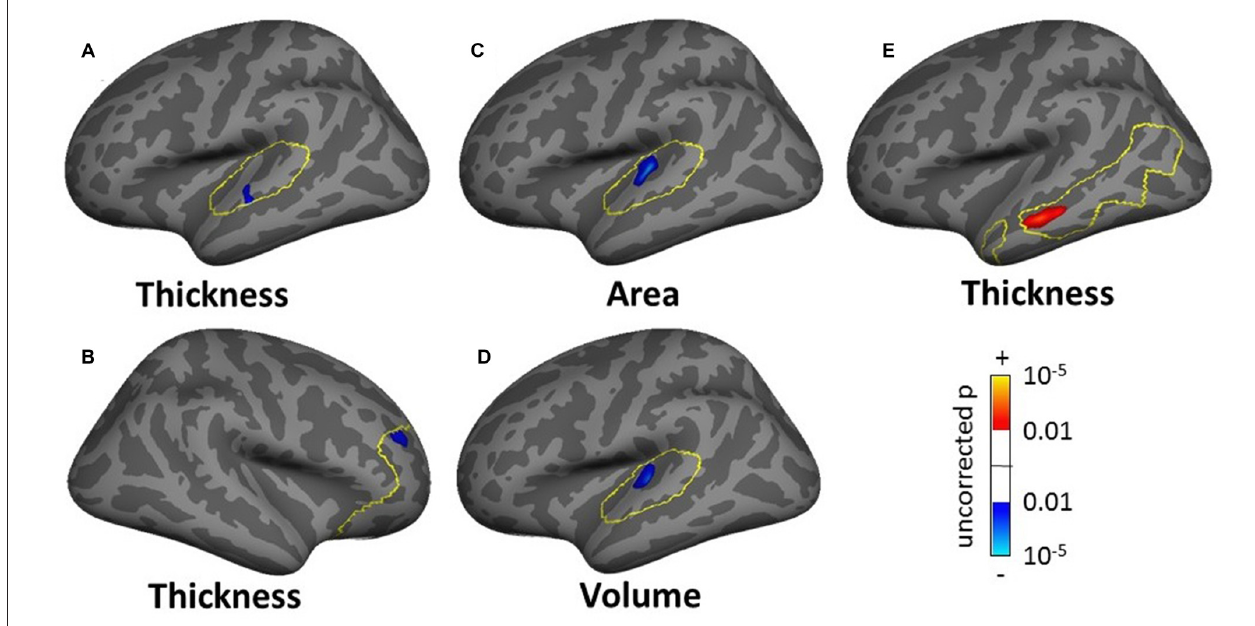
FIGURE 11 | Clusters showing a significant effect ( p < 0.05 FWE-corrected) of tinnitus in left AC (A) and right rostromedial frontal cortex (B) of tinnitus severity in left HG (C,D) and left MTG (E) in the masked SBM analyses. The yellow outlines depict the masks used to restrict the vertexwise analysis (AC for A,C,D ; PFC for B ; DMN for E ). Blue areas correspond to a negative effect (decrease in thickness for the normal-hearing tinnitus group vs. matched controls in (A,B) decrease in area and volume with increasing tinnitus severity in (C,D) and the red areas to a positive effect (increasing thickness for increasing tinnitus severity in (E)